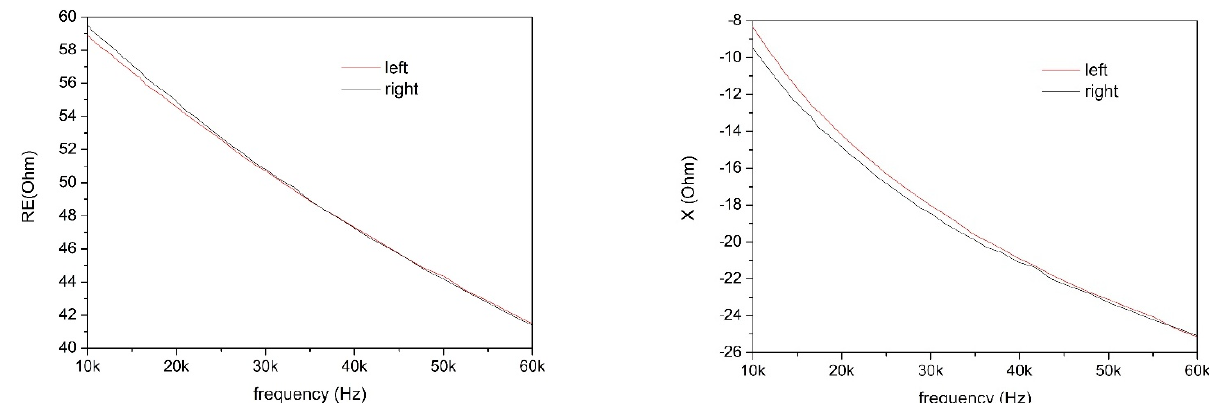
Figure 10. Resistance and reactance of the bioimpedance of subject S3 vs. frequency.